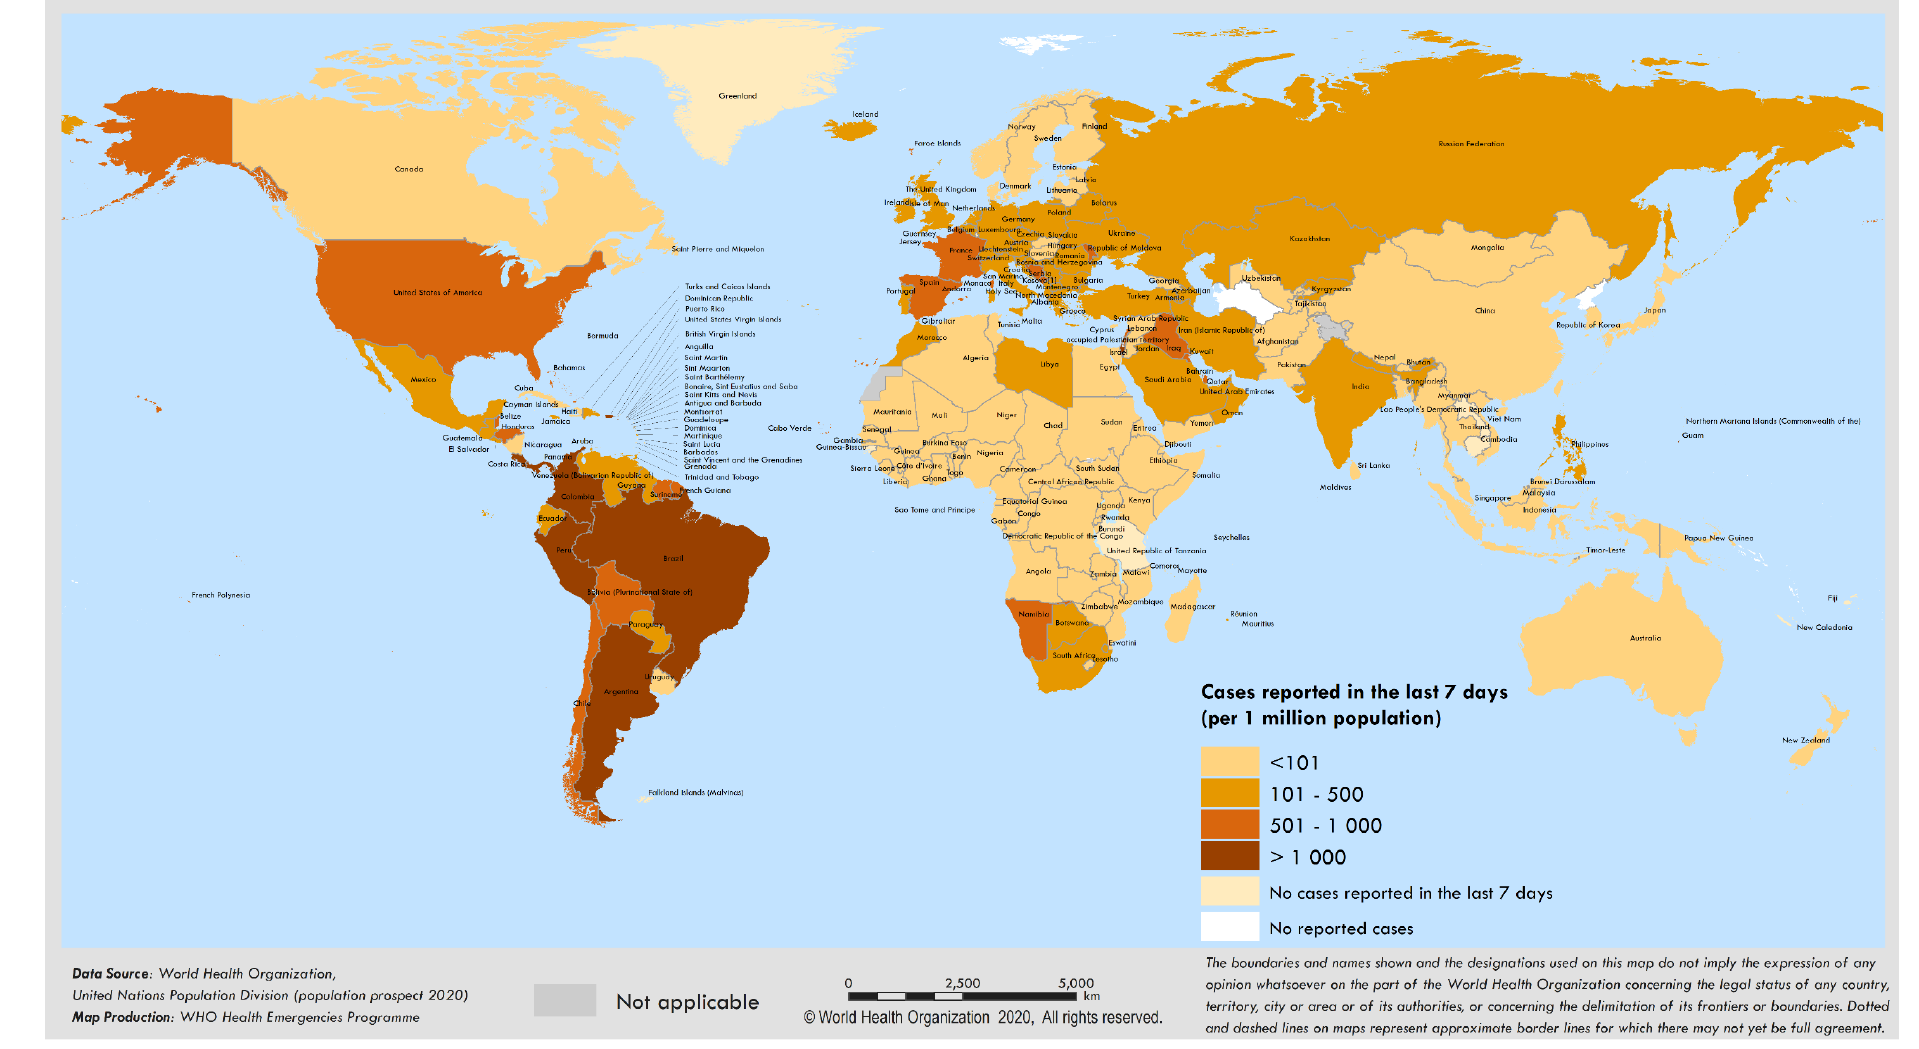
Figure 2. COVID-19 cases per 1 million population reported in the last seven days by countries,territories and areas, 24 August to 30 August